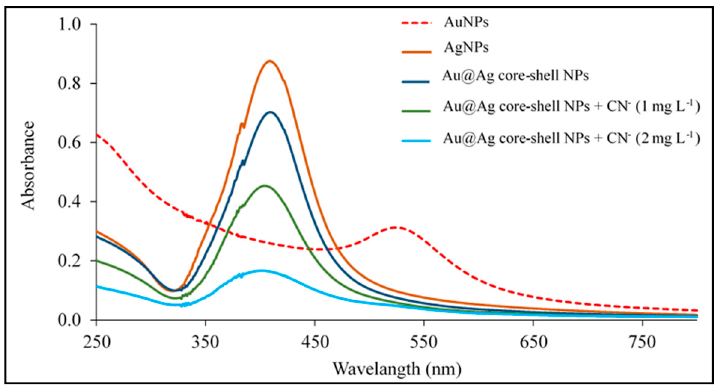
Figure 1. UV-Visible spectra of AuNPs, AgNPs and Au@Ag NPs without and with CN − at 1 and 2 mg L − 1 .